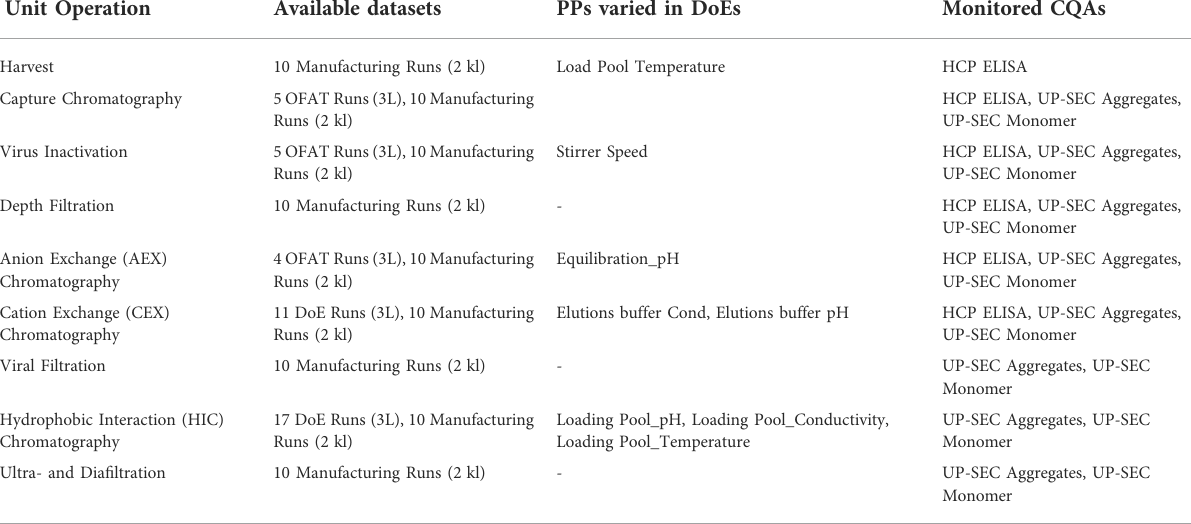
TABLE 1 Available data sets, process parameters, and monitored critical quality attributes (CQAs) for each unit operation included in the